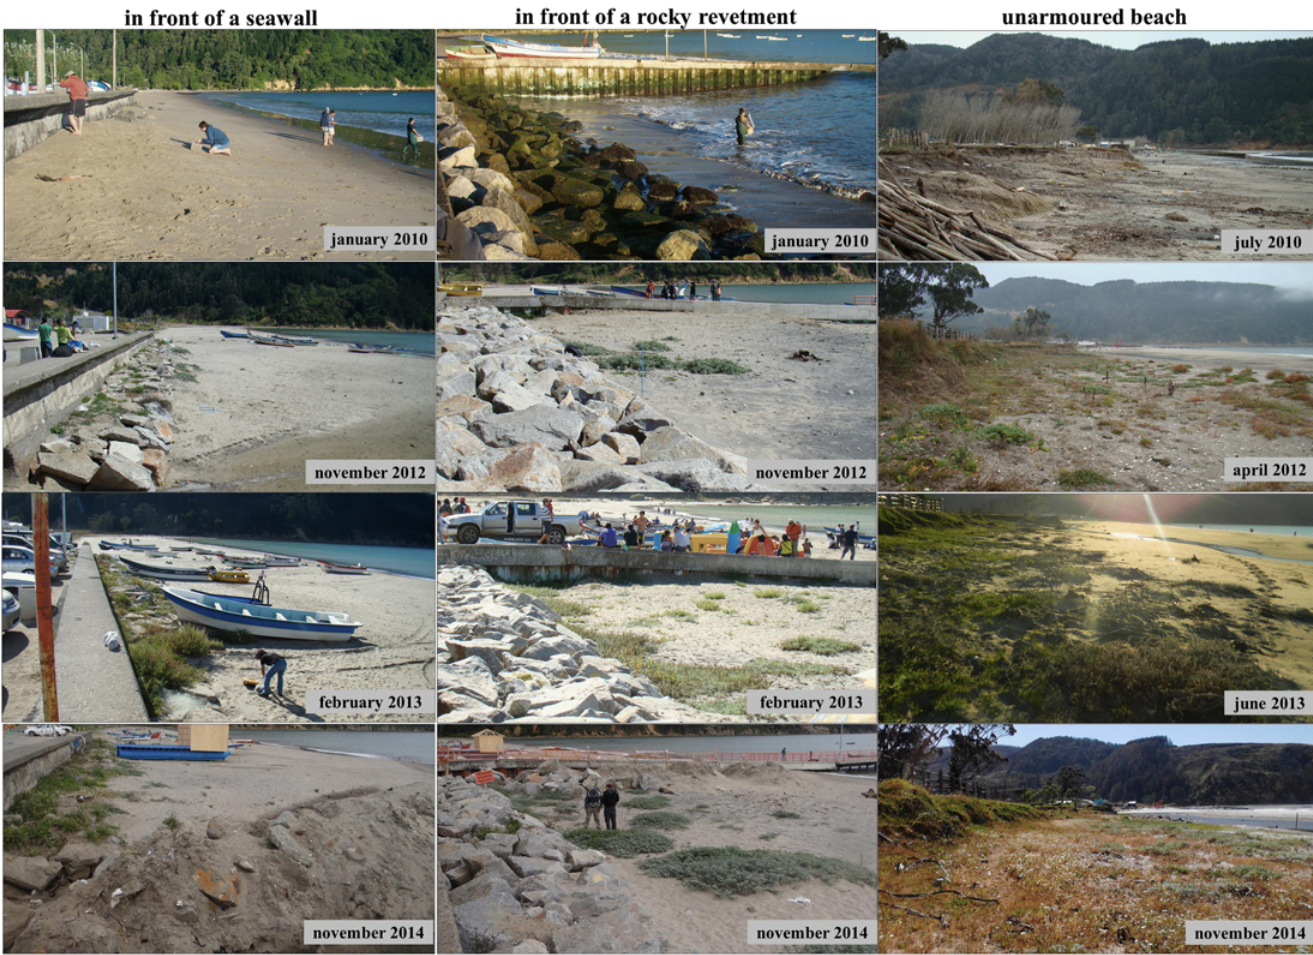
Fig 2. Before/after Maule earthquake (27th February 2010). Pictures of the armoured sites located in front of a seawall and a rocky revetment, and those of the unarmoured site taken at the beach of Llico at different stages of the study. Note the increasing human activities at the seawall site and the developed vegetation at the unarmoured site after the earthquake. Repair work on the concrete wall affected the vegetated zone at that site during November 2014.